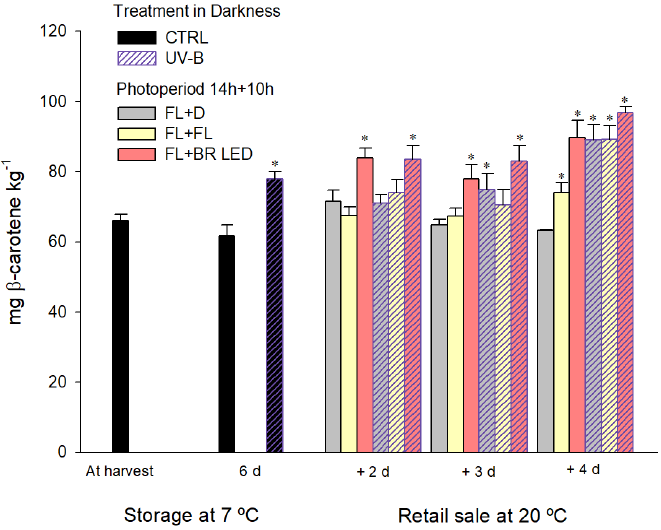
Figure 3. Total β -carotene content of UV-B-treated and untreated CTRL bell peppers after 6 d at 7 °C followed by a retail sale period of 2, 3, and 4 d at 20 °C under different lighting conditions. *: significant differences compared to CTRL. Treatment in darkness (T): CTRL (non-striped bars) and UV-B (striped bars); Photoperiod during retail sale (P): FL+D (grey bars), FL+FL (yellow bars), FL+BR LED (light red bars); and time (t). LSD T = (1.999) ††† ; LSD P = (2.449) ††† ; LSD t = (2.449) ††† ; LSD T×P = (3.463) ††† ; LSD T×t = (3.463) ††† ; LSD P×t = n.s.; LSD T × P × t = (5.998) †† . n.s.: no significant; †† : p > 0.005; ††† : p > 0.001.